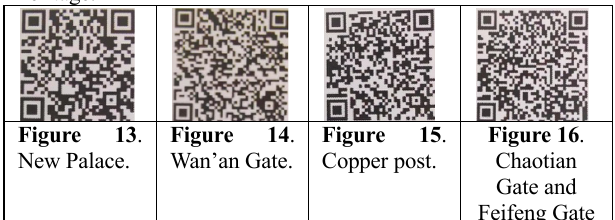
Figure Figure 14 .